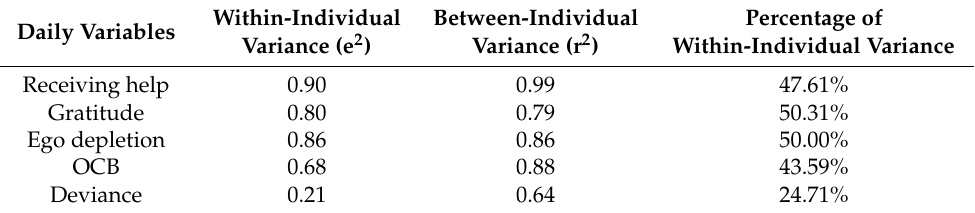
Table 2. Percentage of within-individual variance among daily